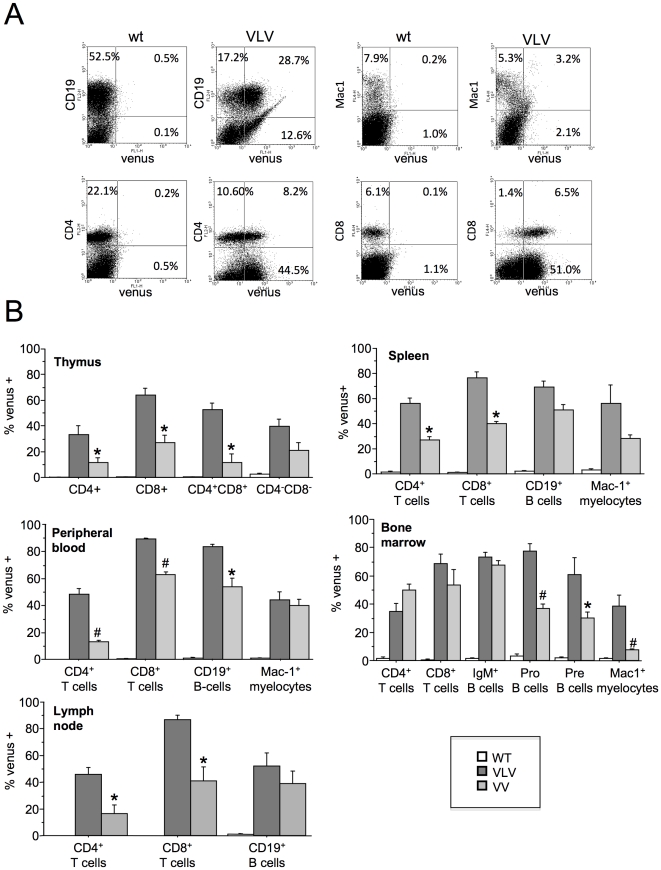
Characterization of transgene expression in haematopoietic cells from VLV and VV mice.Animals that proved positive for Venus expression in the peripheral blood were sacrificed for further analysis of transgene expression in different organs. (a) Single cell suspension from spleens were stained with fluorochrome labeled antibodies specific for cell surface markers identifying T cells (CD4, CD8), B cells (CD19), as well as myelocytes (Mac-1) and subjected to flow cytometric analysis. Representative dot blots showing variegate expression of the transgene are shown. (b) Summary of the experiments shown in (a), performed to assess the percentage of transgene expressing leukocytes in all major haematopoietic organs. Bars represent means ± SEM (wt n = 8, VLV n = 5, VV = 3); *p<0.001; #p<0.05. P values refer to significant differences in Venus expression between cells derived from VLV and VV mice. F2 generation offspring of VLV founder A3 and F3 generation offspring of VV founder A9 were used for this analysis, as well as transgene-negative littermate controls of both strains.